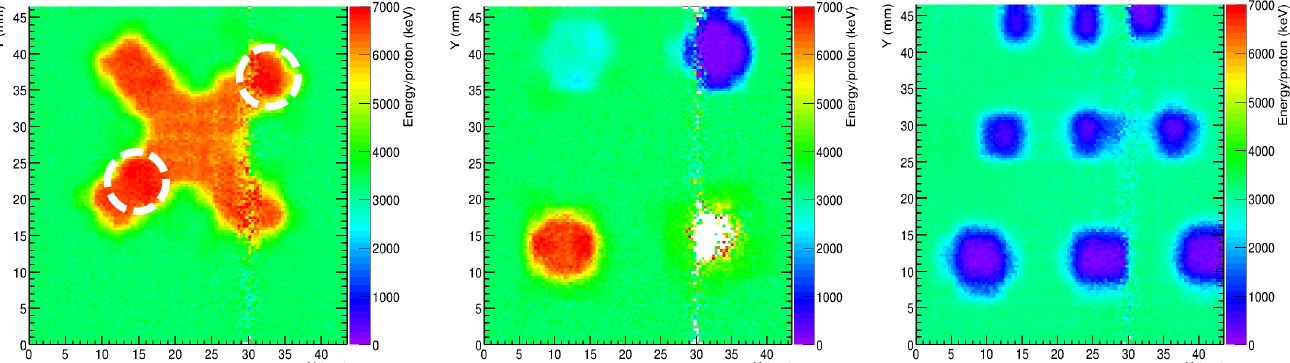
Fig. 5. Set of images obtained at the CMAM facility using a 10-MeV-proton beam of the samples shown in Fig. 4. The colour palette shows the values of deduced energy lost in the sample. The cross-pattern sample is shown on the left, the sample with four regions in the middle and the one with Derenzo pattern on the right side. The sample with cross pattern has indicated two regions which appear in red in the image which correspond to thin cellophane-tape layers of ~20 µ m that can be seen in the picture of Fig. 4 and that our system was able to detect.